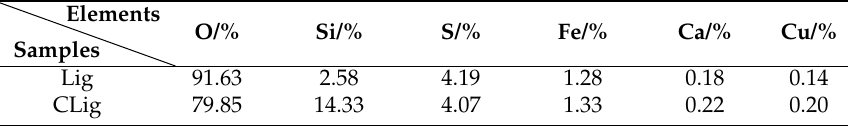
Table 2. Element contents of Lig and CLig obtained by Table 2 . Element contents of Lig and CLig obtained by XRF.